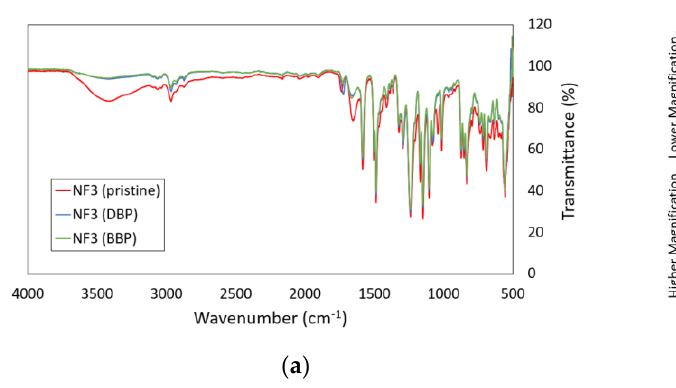
Figure 9. ( a ) FTIR spectrum of pristine NF3 membrane before and after DBP and BBP filtration tests and ( b ) SEM surface images of (i) Pristine NF3 membrane, (ii) NF3 membrane used for DBP filtration and (iii) NF3 membrane used for BBP filtration at two magnifications (5000× and 20,000×).